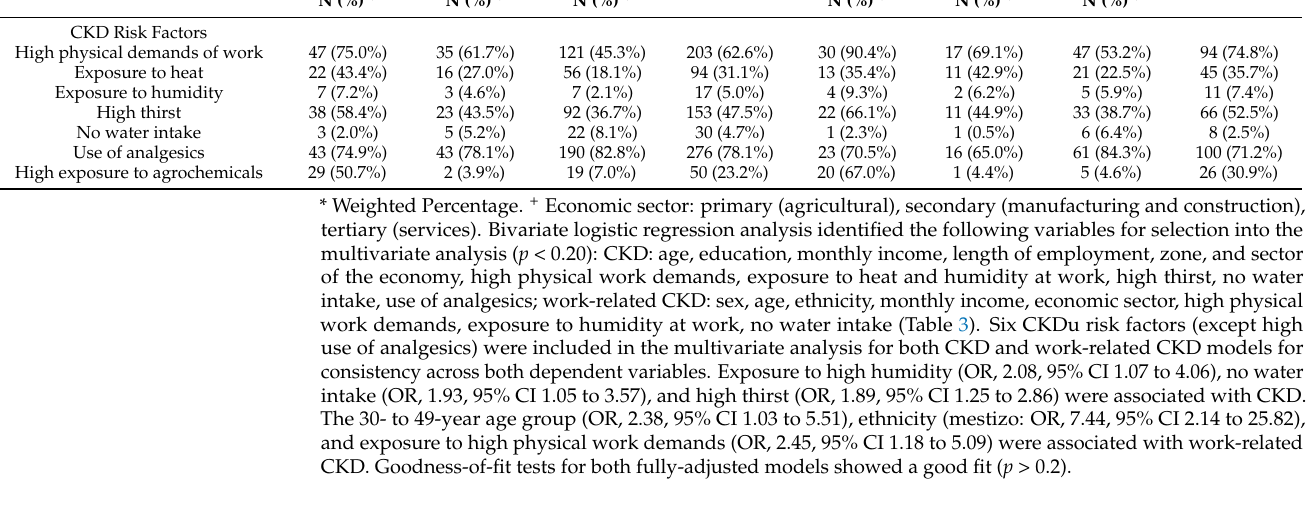
Table 3. Bivariate and multivariate logistic regression analysis of associations between CKD/work- related CKD and risk